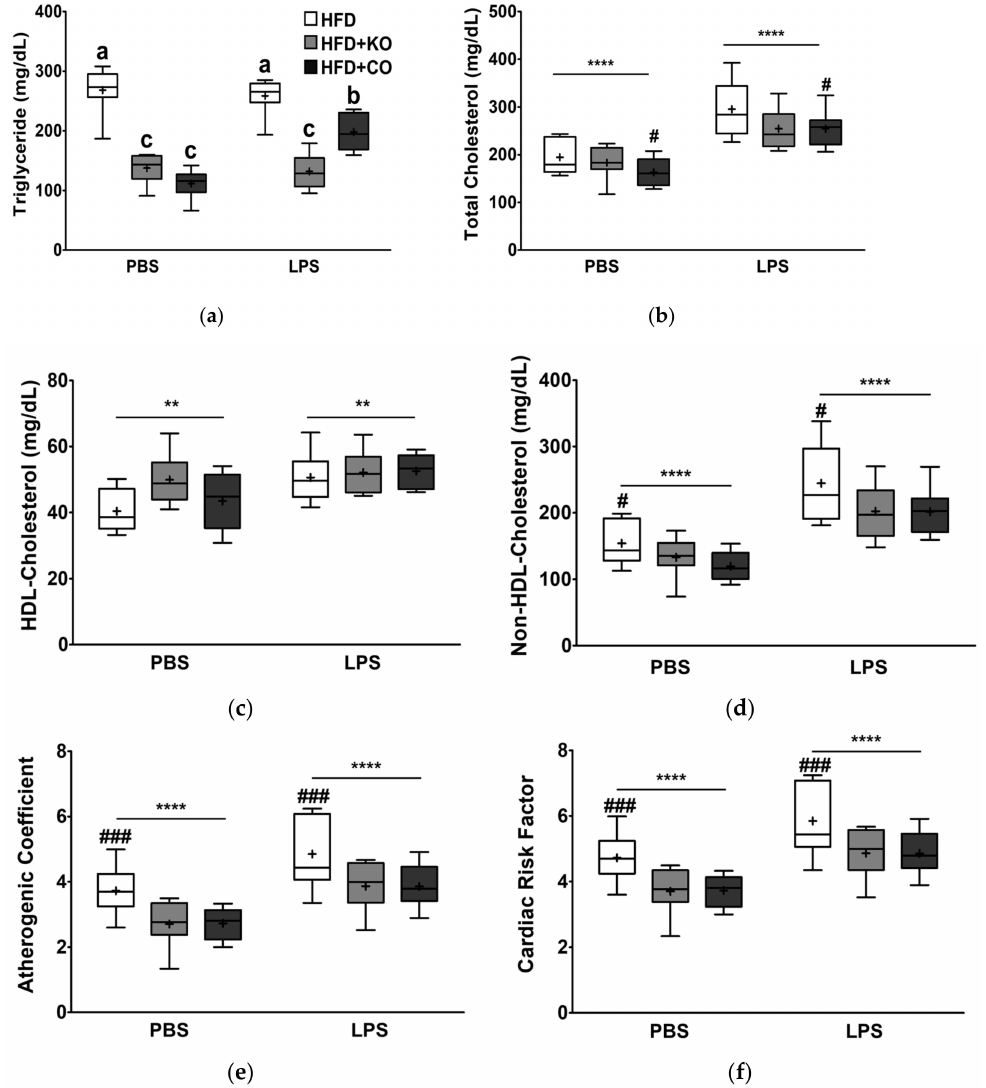
Figure 3. Effects of partial replacement of dietary fat with krill oil or coconut oil on serum lipid profiles and cardiovascular indices in rats after the LPS challenge. Sprague Dawley rats were fed either a high-fat diet (HFD), HFD partially replaced with krill oil (HFD + KO), or coconut oil (HFD + CO) for 10 weeks, and then treated with PBS or LPS (1 mg/kg) for 24 h. ( a ) Serum triglyceride, ( b ) total cholesterol, ( c ) high-density lipoprotein (HDL)-cholesterol, ( d ) non-HDL cholesterol levels, ( e ) atherogenic coefficient (AC), and ( f ) cardiac risk factor (CRF) were measured. Values are displayed as box-and-whisker plots; n = 8 per individual group. Data were analyzed by two-way ANOVA followed by Tukey’s multiple comparisons test to determine the interactions or the main effects (diet and LPS stimulation. Asterisk indicates a significant main effect for LPS (** p < 0.01, **** p < 0.0001). Pound indicates a significant main effect for diet ( # p < 0.05, ### p < 0.001). Labeled means without a common letter differ significantly, p < 0.05. The mean values are indicated by “+” signs. HFD, high-fat diet; HFD + KO, high-fat diet + krill oil; HFD + CO, high-fat diet + coconut oil; PBS, phosphate-buffered saline; LPS,